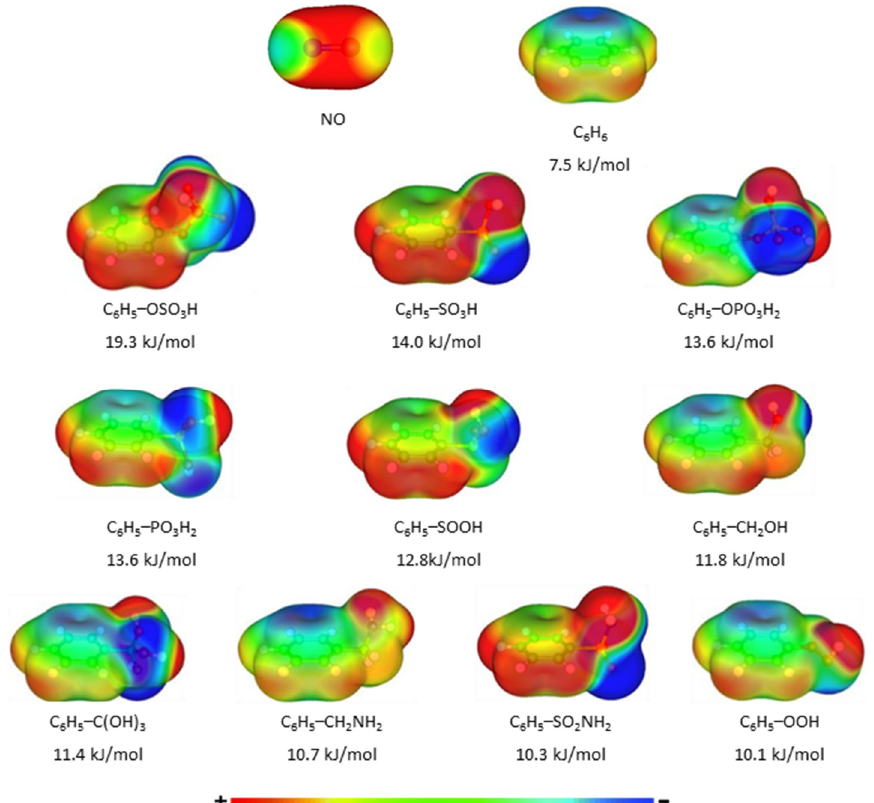
Figure 5. The electrostatic potential maps for the 10 most energetically favorable dimers. Calculated using ORCA 4.2 and visualized using gOpenMol [27,28]. The varying intensities range from −0.03 to +0.03 Hartree·e −1 . Red: electron-poor regions—high-potential value; blue: electron-rich regions— low-potential.